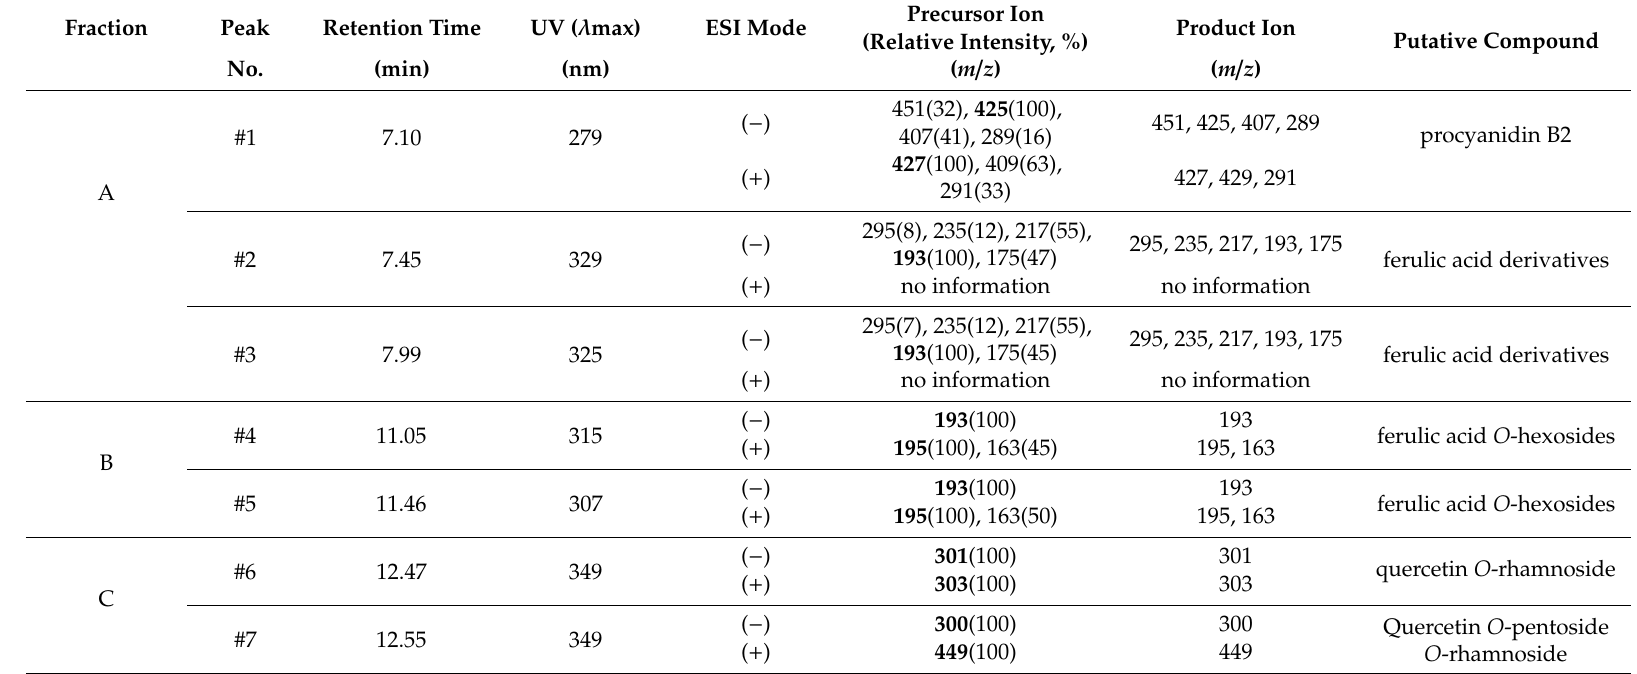
Table 3. Observed peaks in ESI–LC / MS